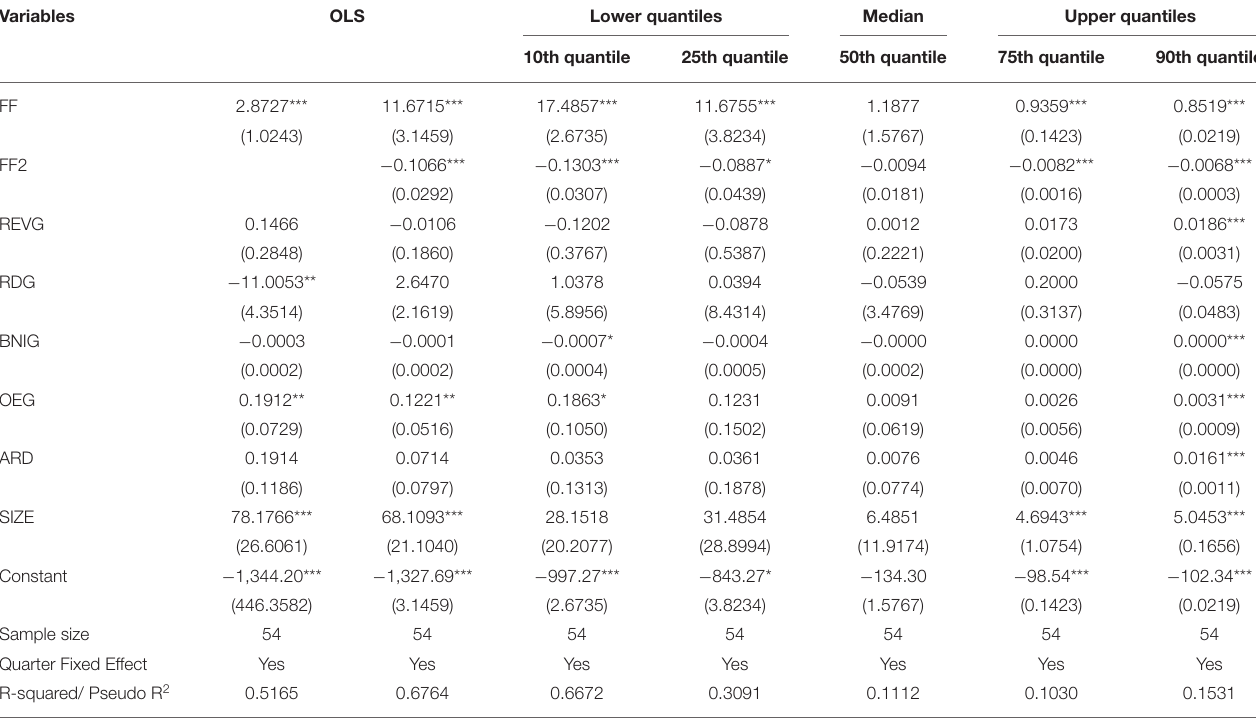
TABLE 7 | Quantile regression results of the ALBM hotel